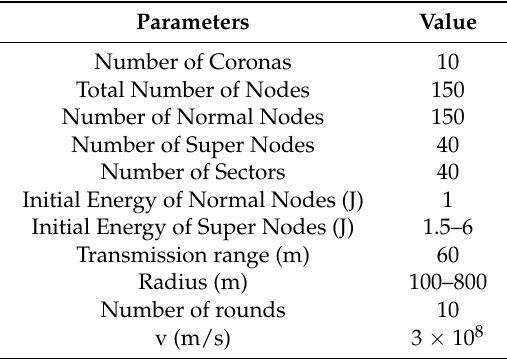
Table 2. Control